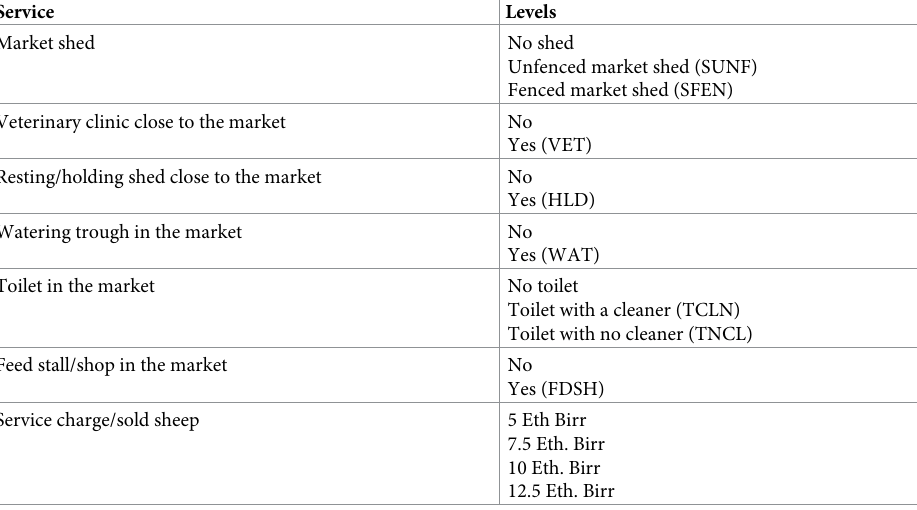
Table 1. Services (attributes) and delivery levels in the discrete choice experiment. Service